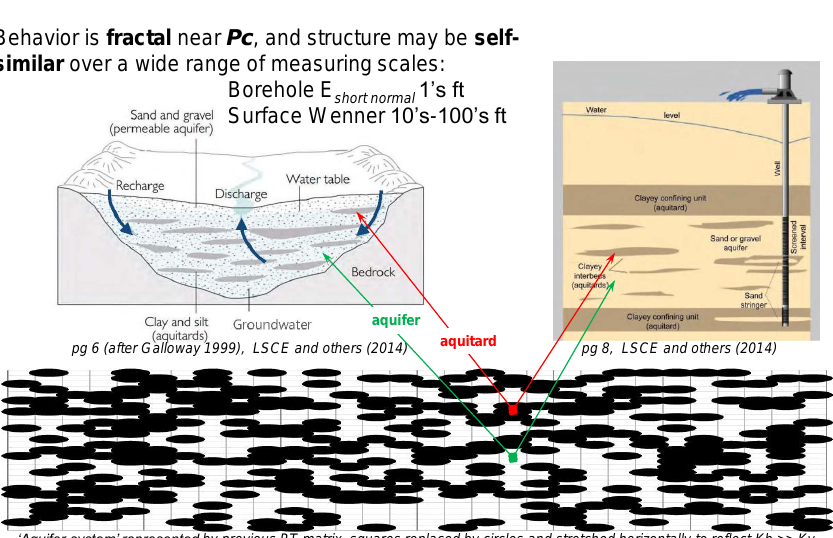
Figure 1. Basic PT (Sukop et al., 2002) site-percolation model (Fig. 1a top) is modified to address basin alluvium connectivity and behaviour (Fig. 1b